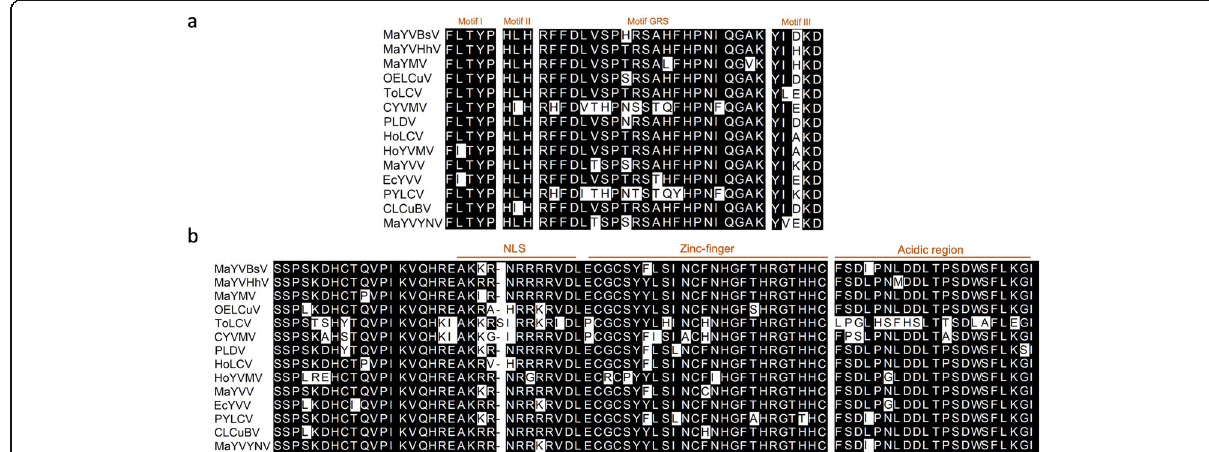
Fig. 2 Multiple alignments of protein sequences from MaYVBsV, MaYVHhV and other begomiviruses. a An alignment of Rep sequences of MaYVBsV, MaYVHhV and other begomoviruses. The four conserved motifs I (DNA binding), II (metal binding), GRS (Geminivirus Rep Sequence) and III (DNA cleavage and ligation) are indicated. b An alignment of C2 protein sequences of MaYVBsV, MaYVHhV and other begomoviruses. The positions of functional regions are indicated